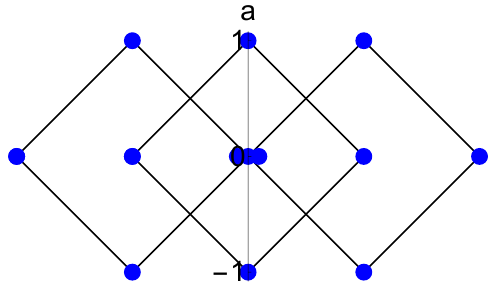
Figure 7 . Homological diagram for 6 3